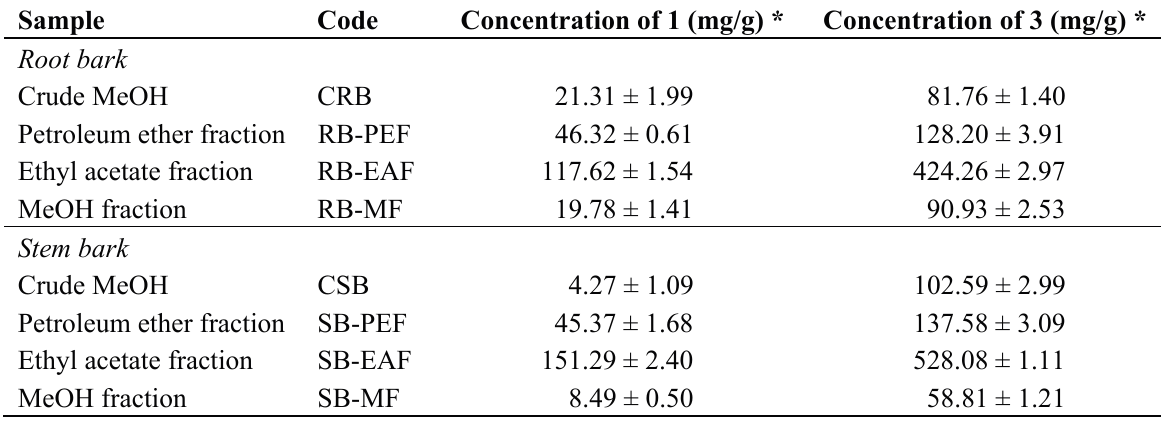
Table 1. Concentrations of koetjapic acid ( 1 ) and betulinic acid ( 3 ) in the crude methanol extracts and fractions of Dillenia serrata